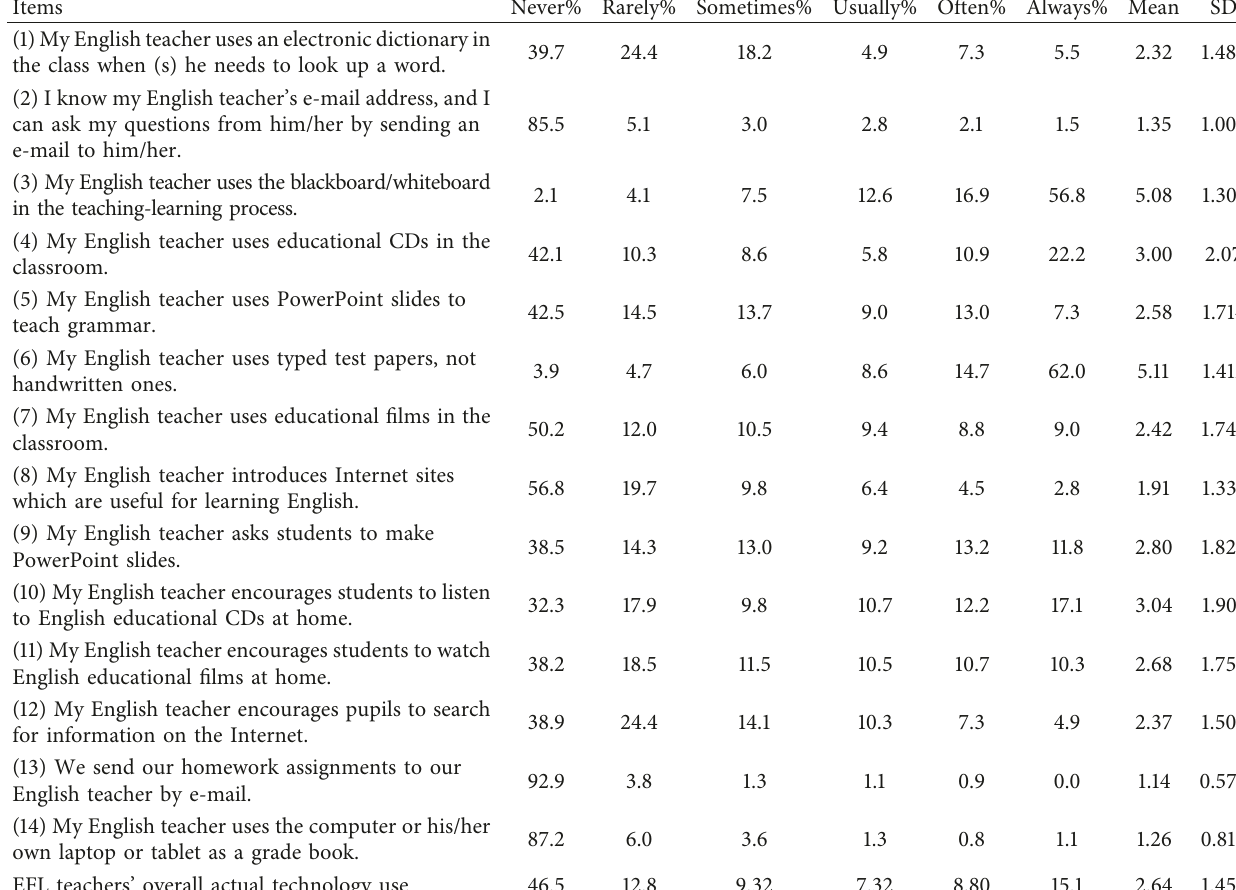
Table 5: Questionnaire results for EFL teachers’ actual use of educational technology in their classes.